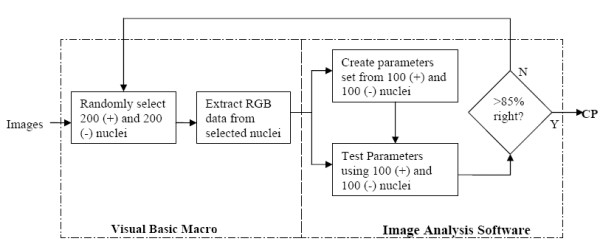
Steps involved in the creation of classification parameters. CP – Classification Parameters.